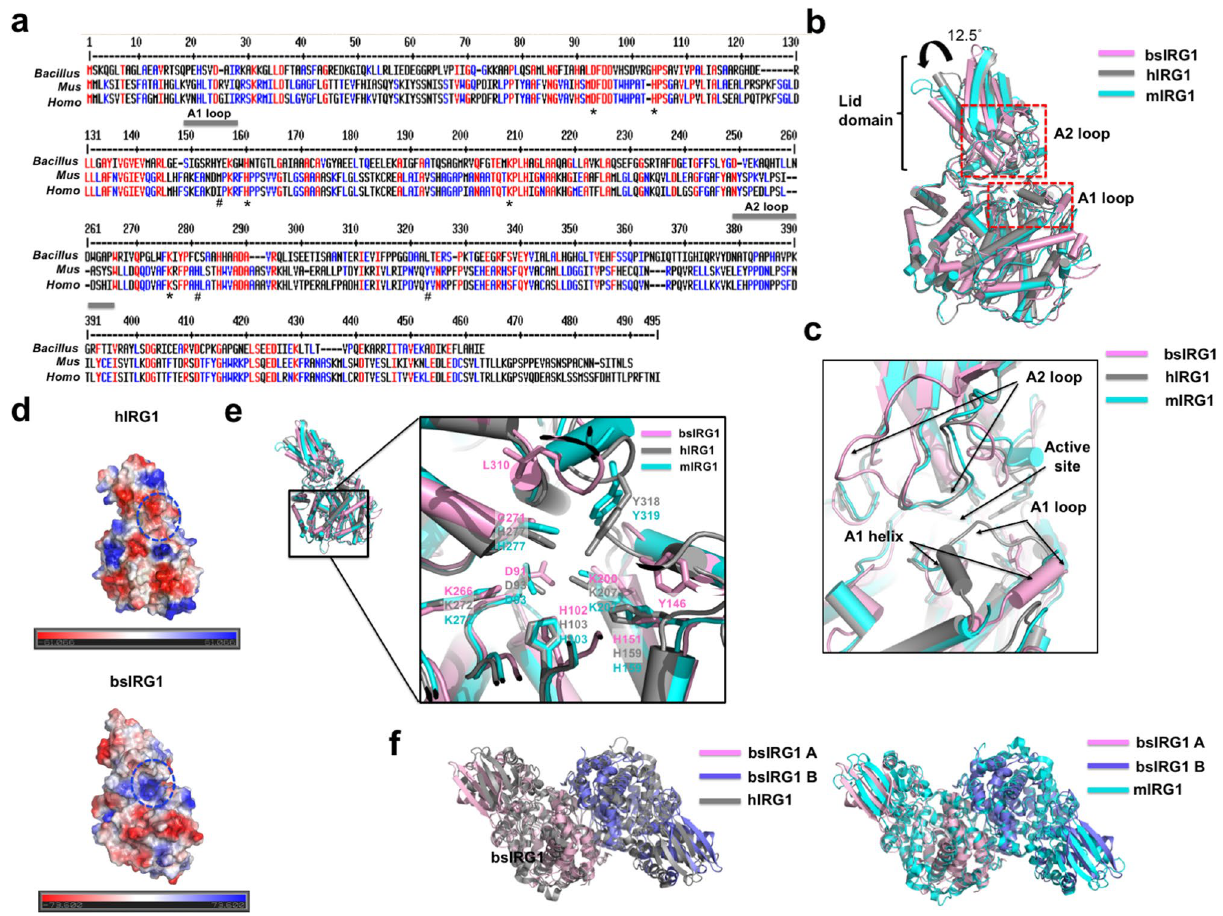
Figure 3. Structural comparison of Bacillus subtilis immune-responsive gene 1 (bsIRG1) with mammalian IRG1—hIRG1, and mIRG1. ( a ) Sequence alignment of bsIRG1 with mIRG1 (IRG1 from Mus musculus ) and hIRG1 (IRG1 from Homo sapiens ). Completely conserved residues and partially conserved residues are indicated in red and blue, respectively. The star (*) and hash (#) symbols indicate the completely conserved residues and unconserved residues in the active site. The positions of the A1 and A2 loops are indicated by the gray bars above the corresponding sequences. ( b ) Superposition of the structure of bsIRG1 with those of the mammalian IRG1s. The dashed red rectangles indicate the locations of the A1 and A2 loops. Based on the locations of the lid domains of mammalian IRG1s, the rotation angle of the lid domain of bsIRG1 is provided above the cartoon. ( c ) Close-up view focused on the loops around the active site. The locations of the A1 and A2 loops and active site are indicated by black arrows. ( d ) Electrostatic surface representation of hIRG1 and bsIRG1. Blue circles indicate the active sites. ( e ) The details of the active site of bsIRG1 compared to those of mammalian IRG1s. The close-up view is provided in the right panel. The residues that form the active site are labeled. ( f ) Comparison of dimeric bsIRG1 with dimeric mammalian IRGs by superposition